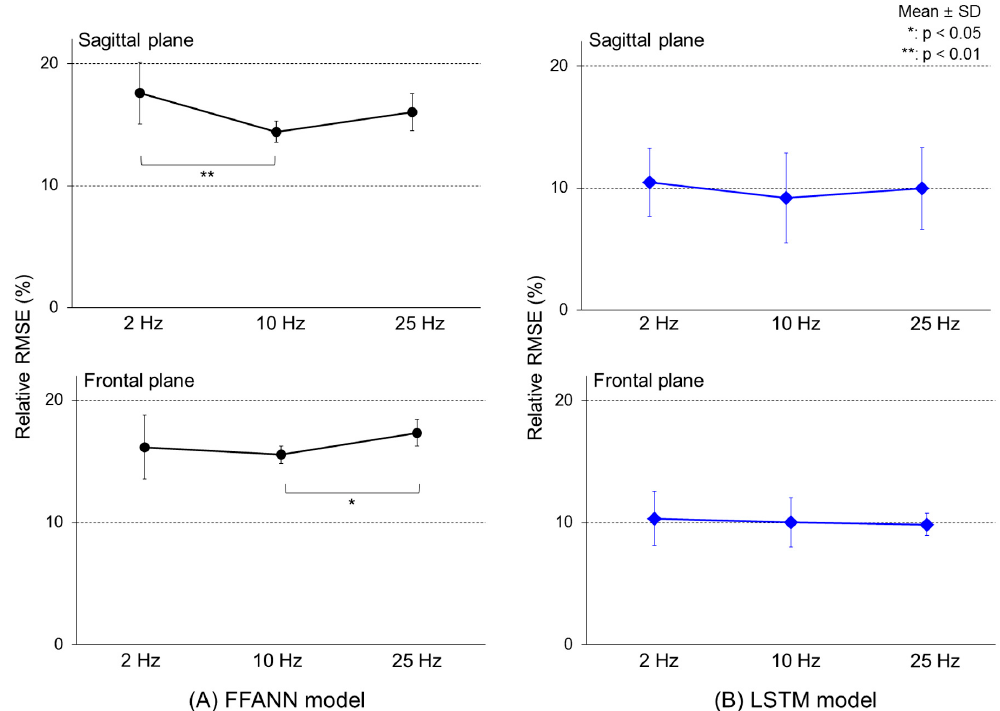
Figure 7. Relative RMSE values between the calculated and predicted COM-COP IA with different cutoff frequencies.